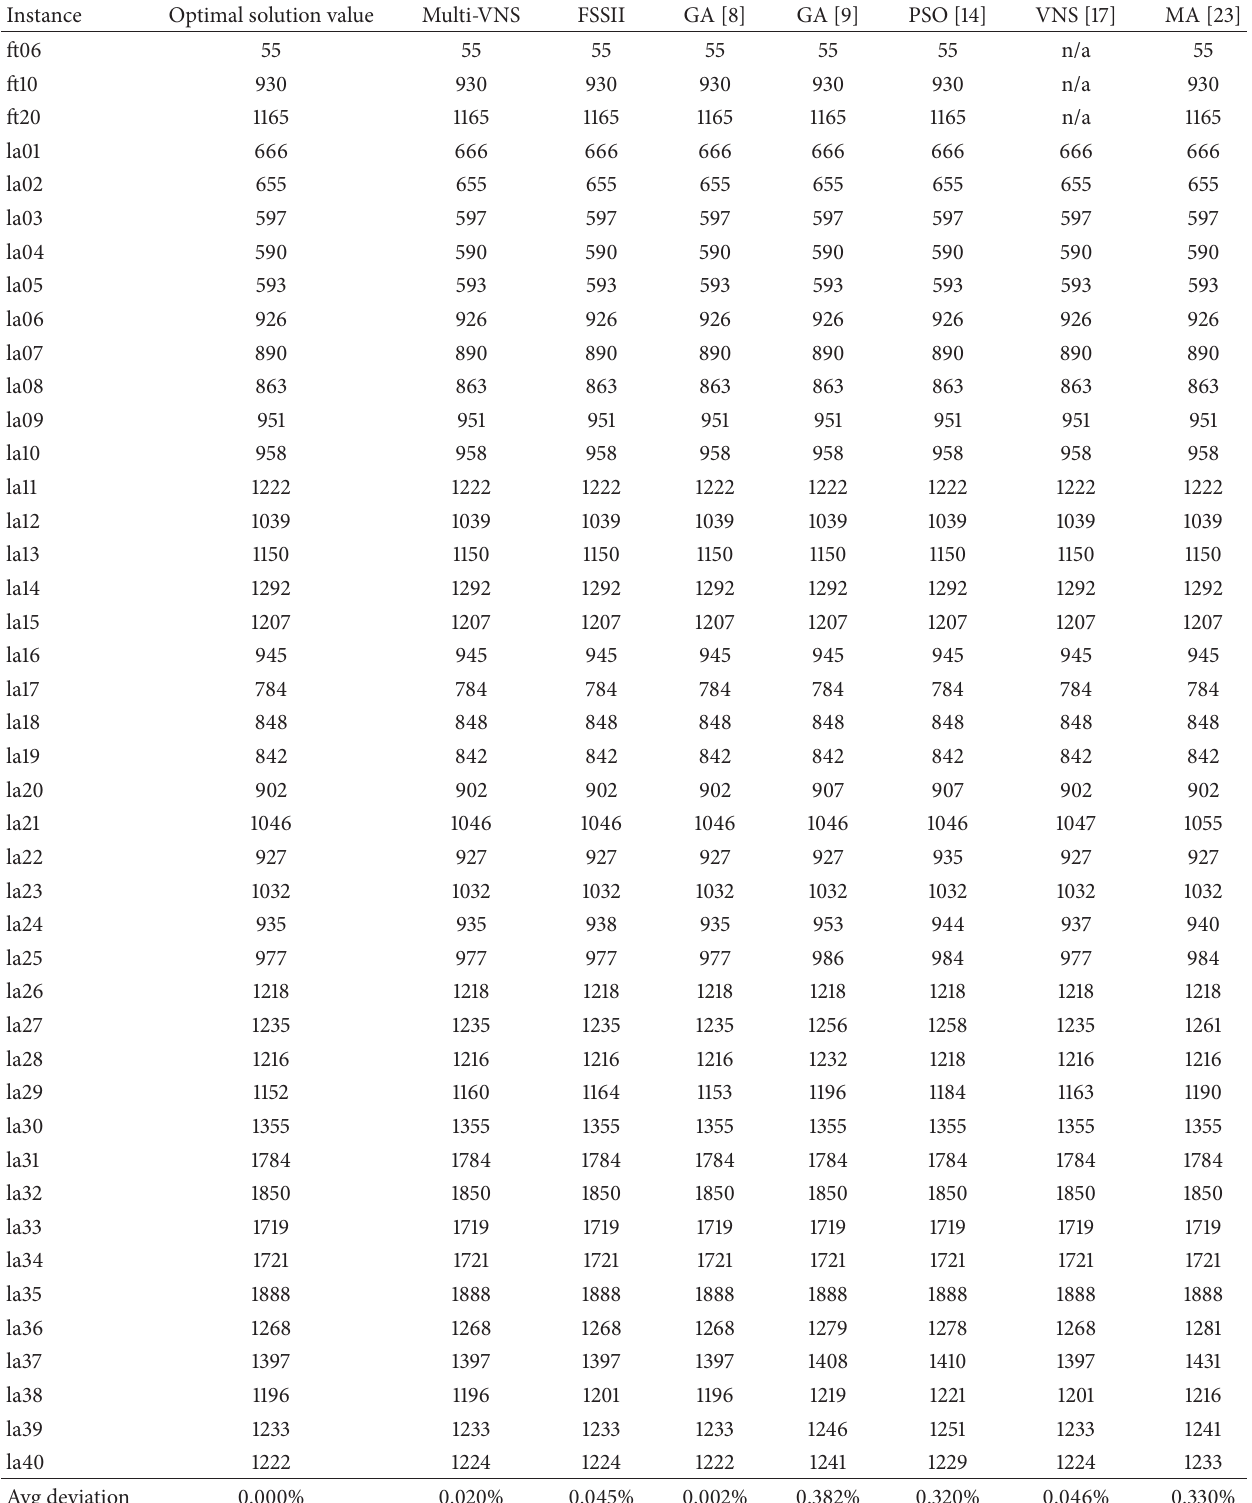
Table 5: Comparison of best found solution values of